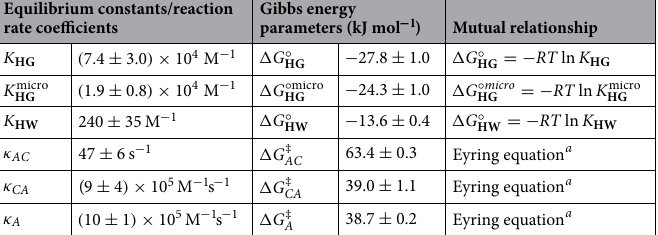
Table 2. Parameters of Gibbs energy profile at T = 298 K. transition probability η = 1 was